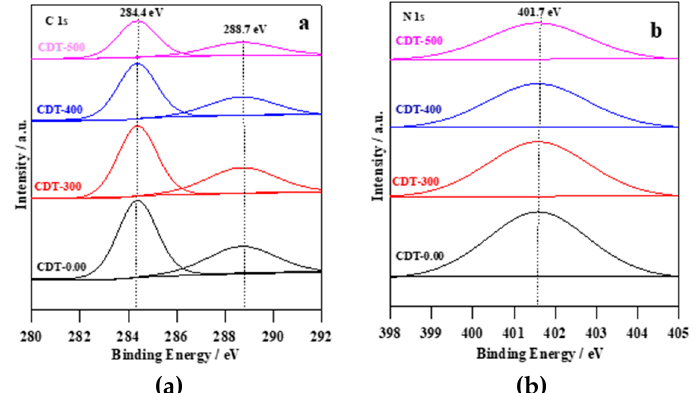
Figure 6. XPS detailed scans in the energy regions of: ( a ) C 1s; and ( b ) N 1s of the obtained photocatalysts.